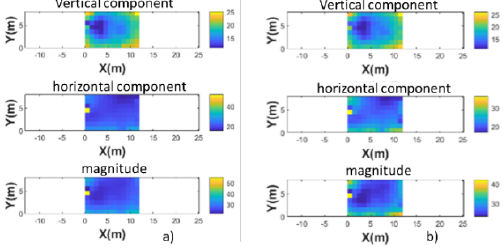
Figure 9. The magnetic feature map of preliminary test